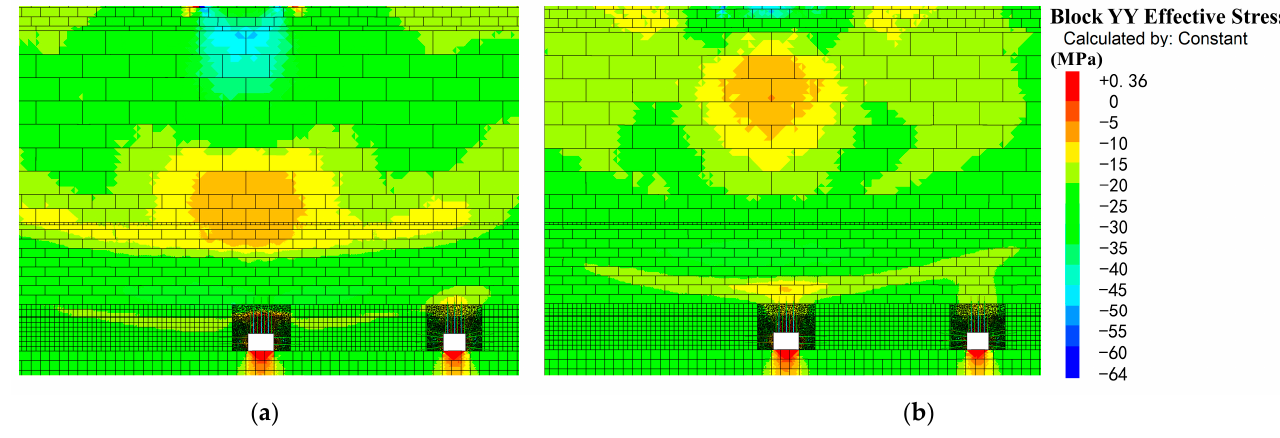
Figure 5. Roadway support parameters.